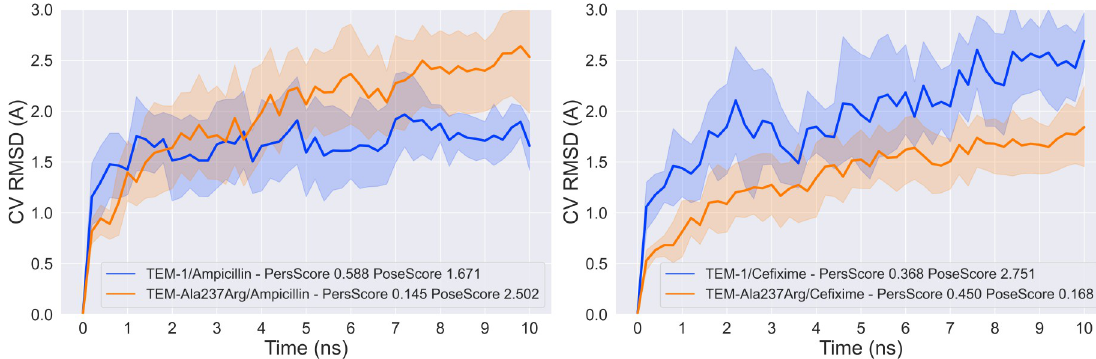
Fig 6. Binding pose metadynamics results for complexes with ampicillin (left) and cefixime (right). In addition to the ligand RMSD, for each set of simulations, we also report a measurement of the stability of the network of hydrogen bonds in the pre-simulation pose, called the PersScore, and the ligand RMSD for the final frame of the simulation in regards to the initial pose, called the PoseScore. All data shown are averaged over ten replicates. The shading denotes the standard deviation of the RMSD values for each system.